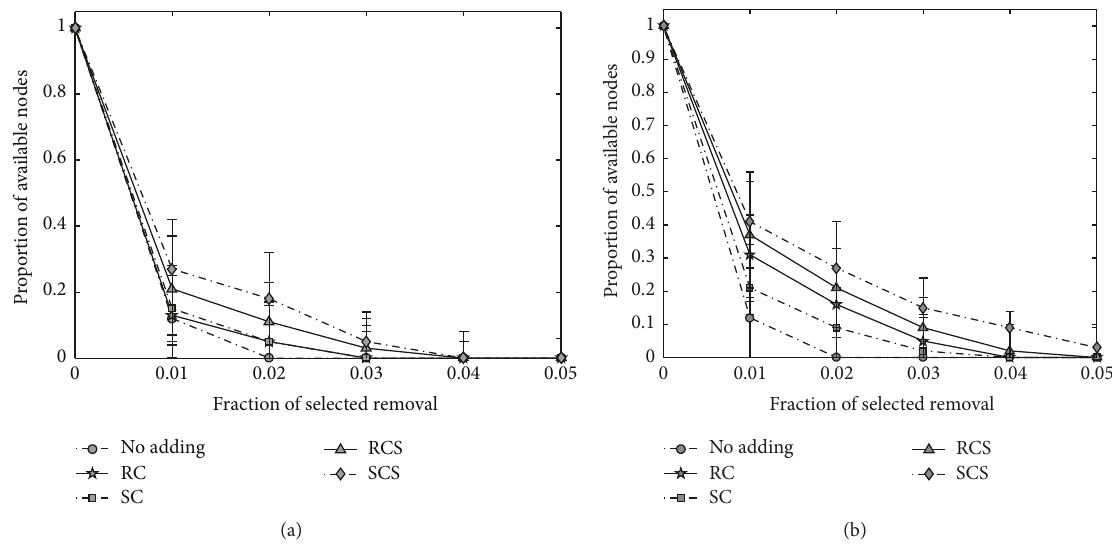
Figure 9: Intrusion tolerance of the network with 𝑞 = 0.01 and 𝑞 = 0.1 . (a) 𝑞 = 0.01 . (b) 𝑞 = 0.1